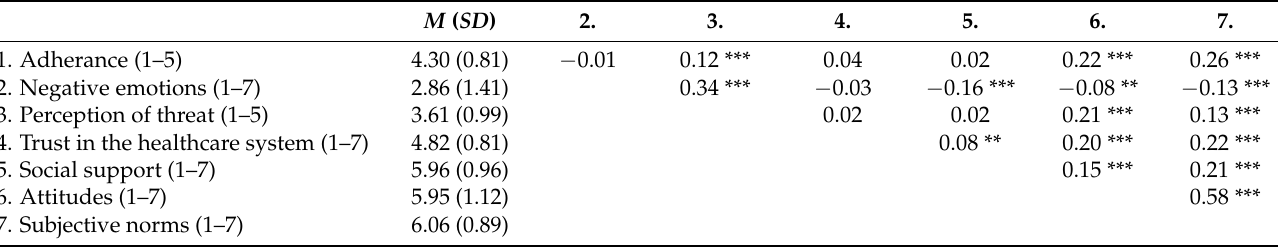
Table 2. Means, standard deviations, and inter-correlations for the study variables ( N =